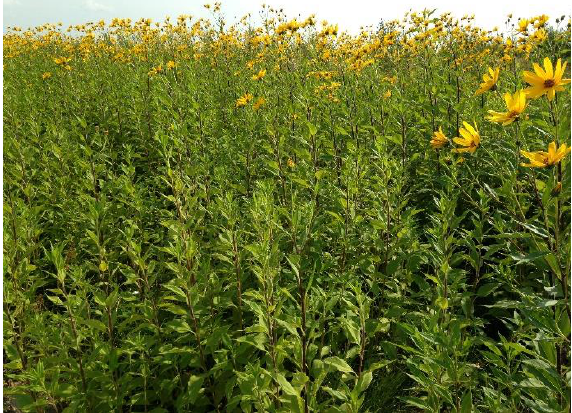
Figure 1. Areas planted with artichoke at the farm household headed by E.I. Stroeva, an individual entrepreneur (village Serebrovo, Kameshkovskiy district, Vladimir region).